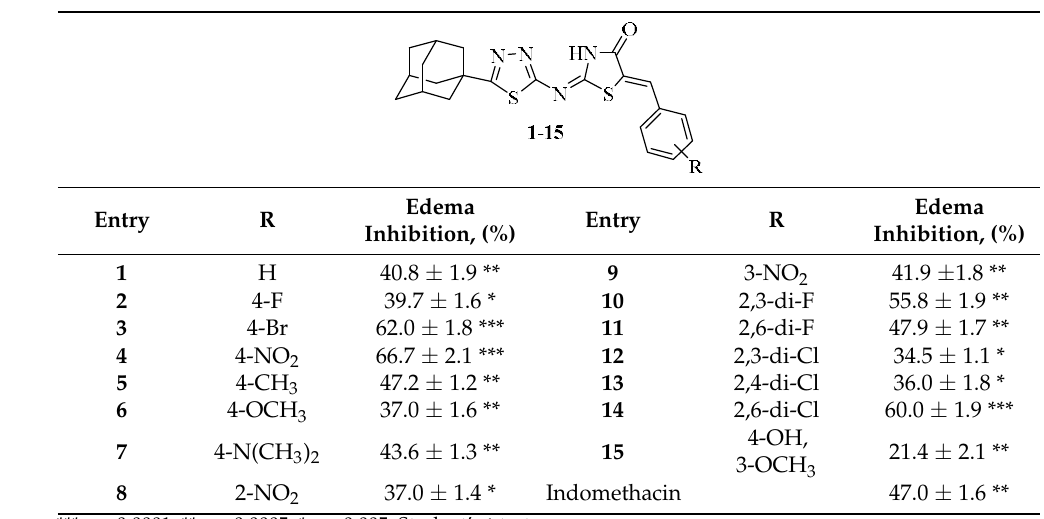
Table 1. Anti-inflammatory activity of the titled compounds.